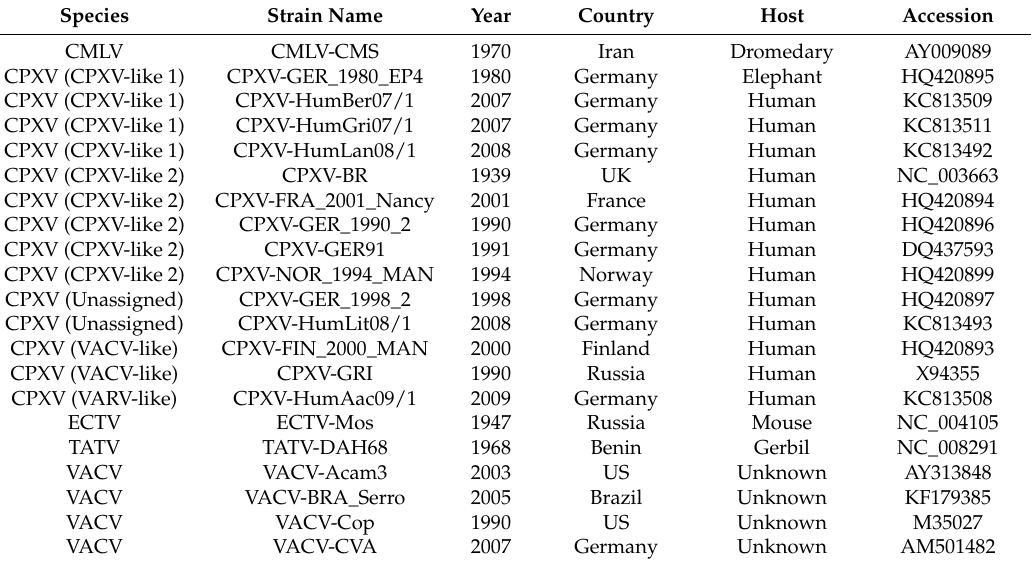
Table 1. Orthopox viruses included in phylogenetic